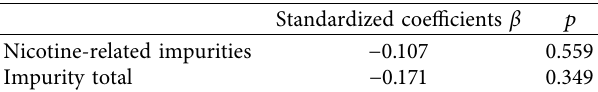
Table 3: The multiple linear regression of the relative difference in nicotine levels on nicotine-related impurities and total